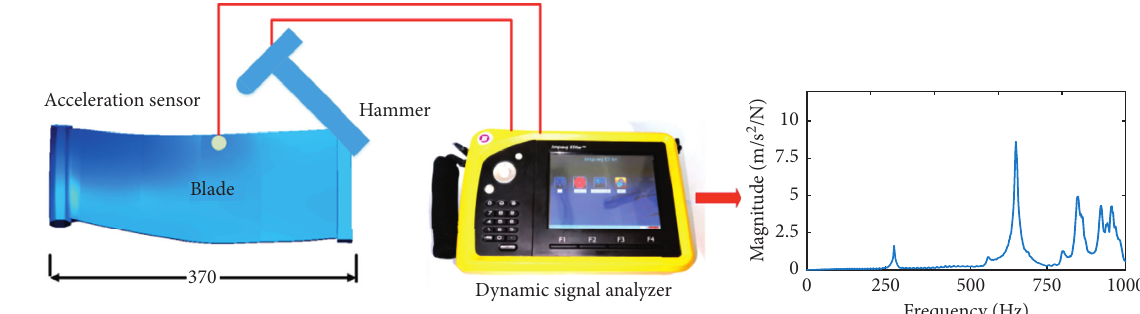
Figure 3: Measuring and analyzing the FRF curve.